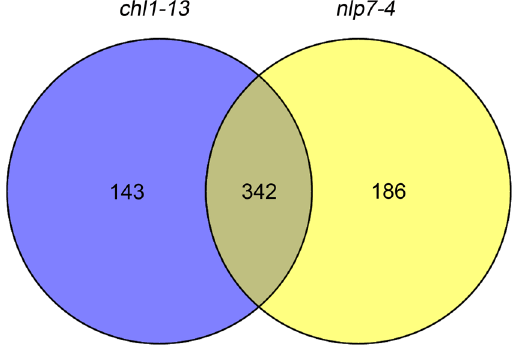
Figure 4. Venn diagram displaying the number of genes that are differentially expressed in chl1-13 and nlp7-4 mutant roots compared with WT. Seedlings were planted on the medium with 2.5 mM ammonium succinate for 7d followed by nitrate treatment.